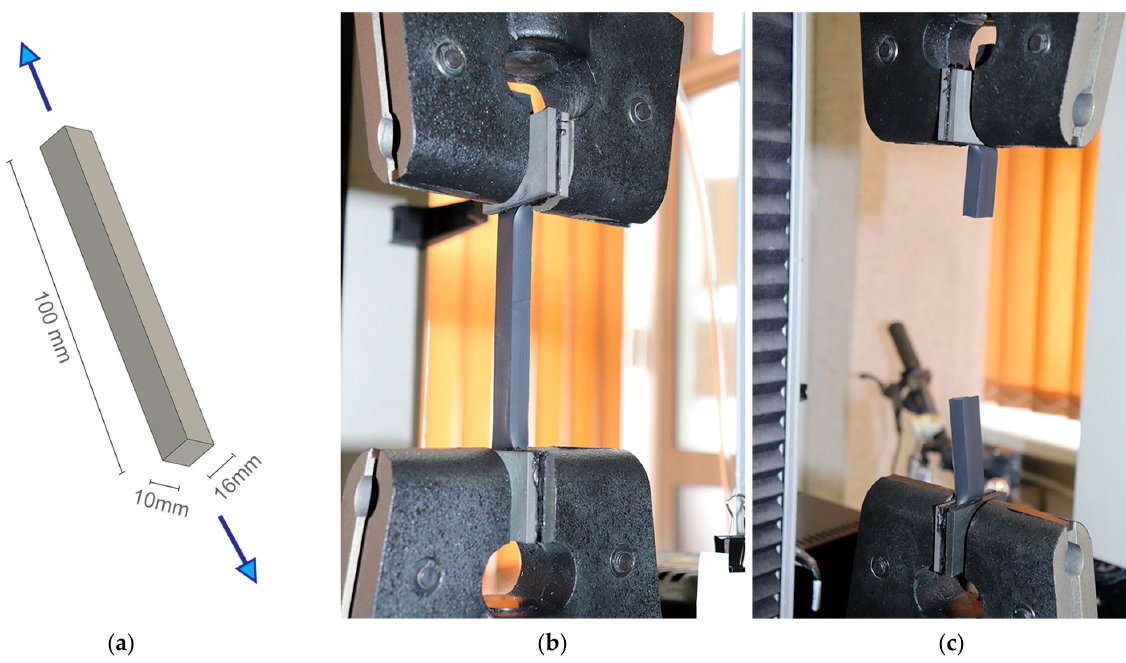
Figure 7. Testing of silicone: ( a ) dimensions of cut out specimens ( b ); tensile test at 23 °C; ( c ) finish after sample break.